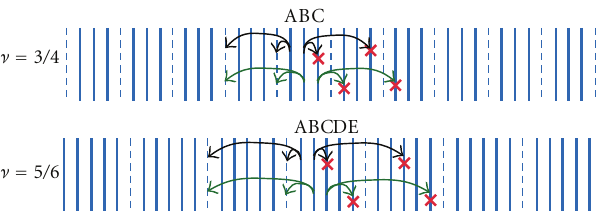
Figure 13: All Coulomb transitions from nearest electron pairs are forbidden.